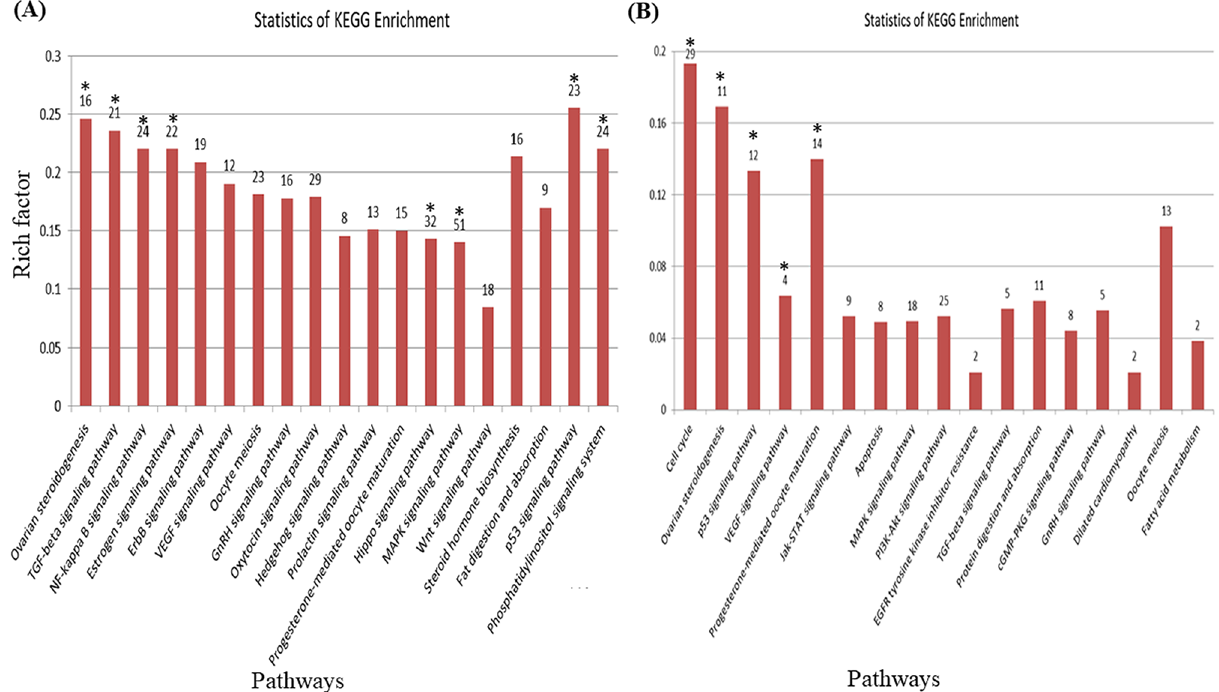
Figure 2. KEGG pathway analysis of differentially expressed mRNAs in ovaries of Hu sheep at ( A ) H1 vs H3 and ( B ) H3 vs H8. H1, H3 and H8 represent ovaries sampled at 1, 3 and 8 months old, respectively. The x-axis represents the name of the pathway, and the y-axis represents the rich factor corresponding to each pathway (the number of differential mRNA enriched in each pathway/the number of all genes enriched in this pathway in the background gene concentration). The numbers on top of each bar represent the number of differential mRNA enriched in each pathway. Bars with * indicates those highly significant enriched with p value ≤